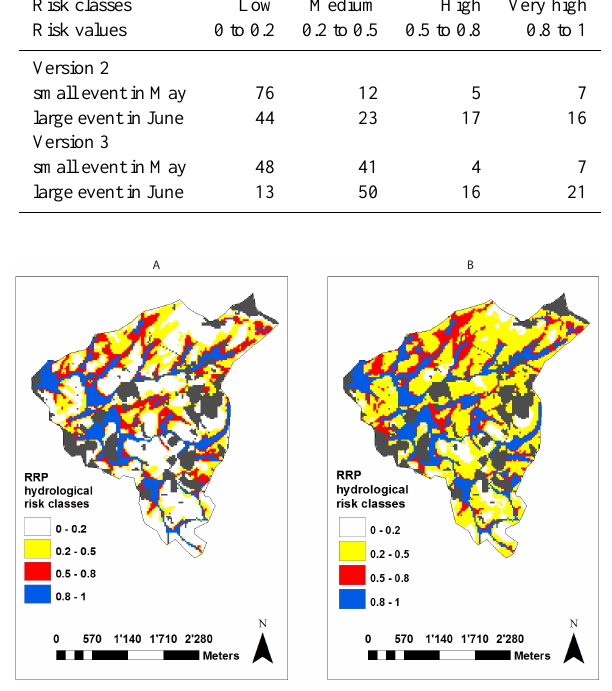
Fig. 6. Risk maps for the large event of June 2010 in the Stägbach catchment, obtained with model versions 2 (left) and 3 (right). Grey shading denotes forested and urban